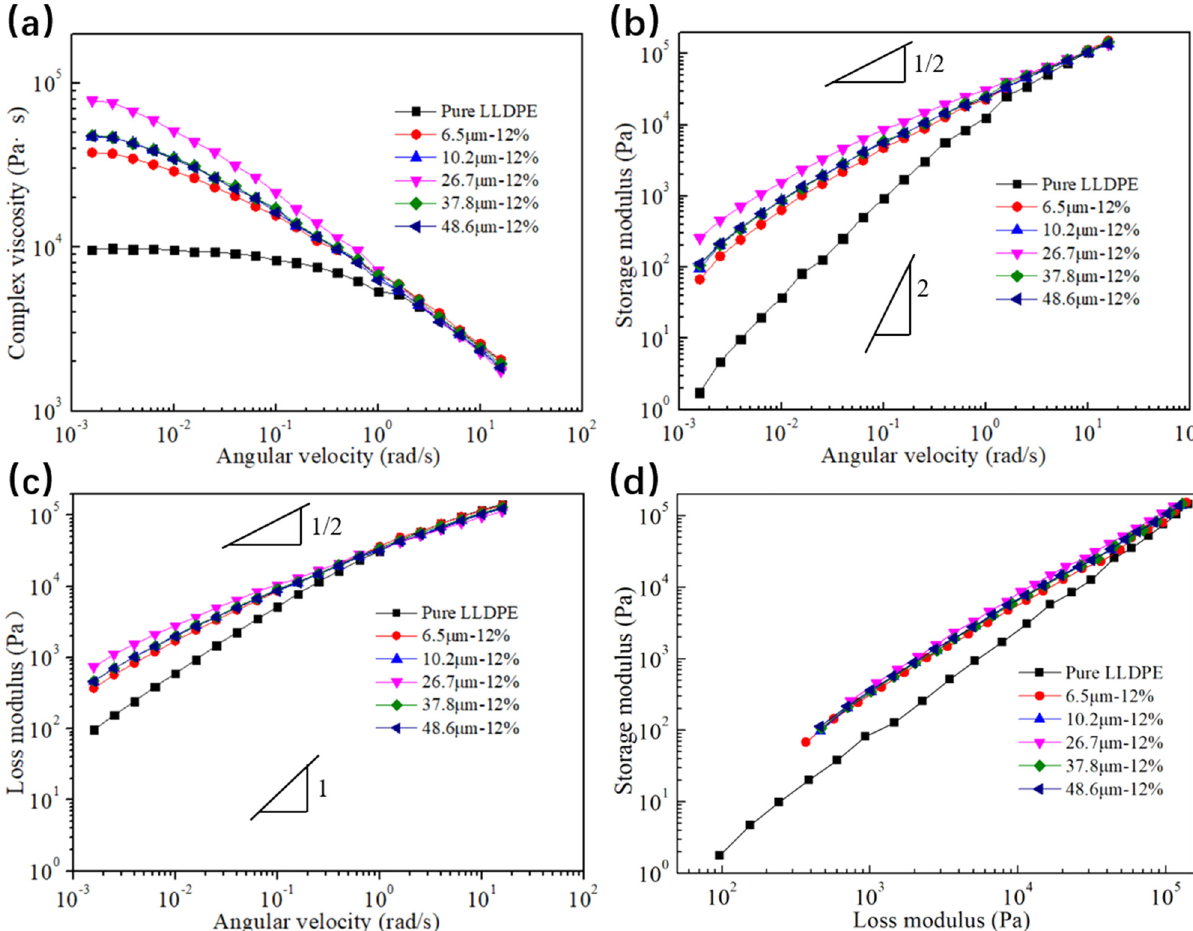
Figure 5: Dynamic rheological properties of the Al 2 O 3 /LLDPE composites with di ff erent Al 2 O 3 particles diameters: ( a ) complex viscosity, ( b ) storage modulus G ′ , ( c ) loss modulus G ″ , and ( d ) Han